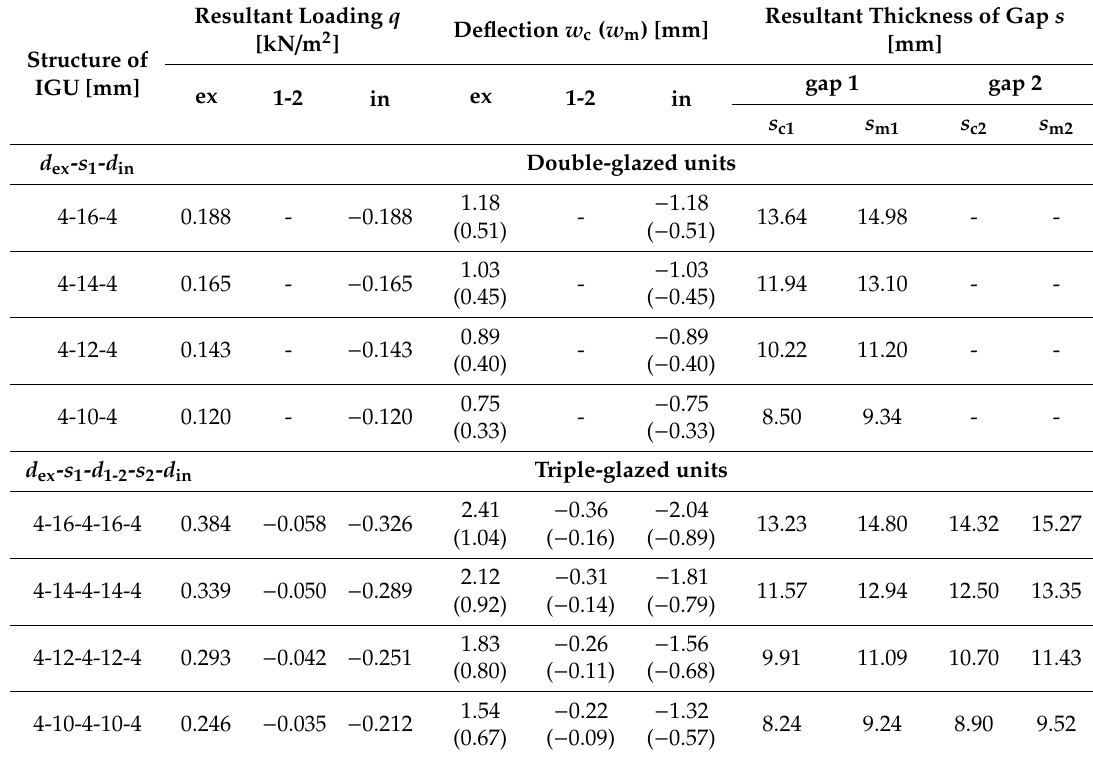
Table 4. Static quantities and gap thicknesses in IGUs under conditions for a “mild winter” (Variant 2) and atmospheric pressure increase by ∆ p = 3 kPa.